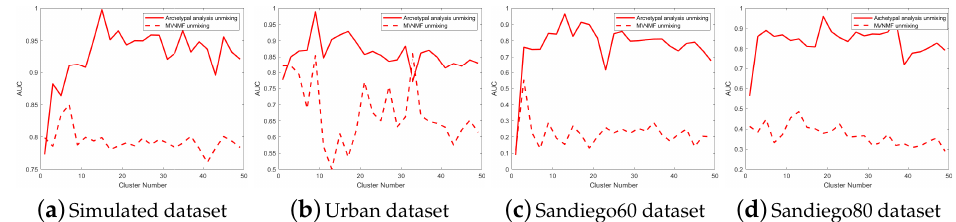
Figure 20. Detection accuracy of different unmixing